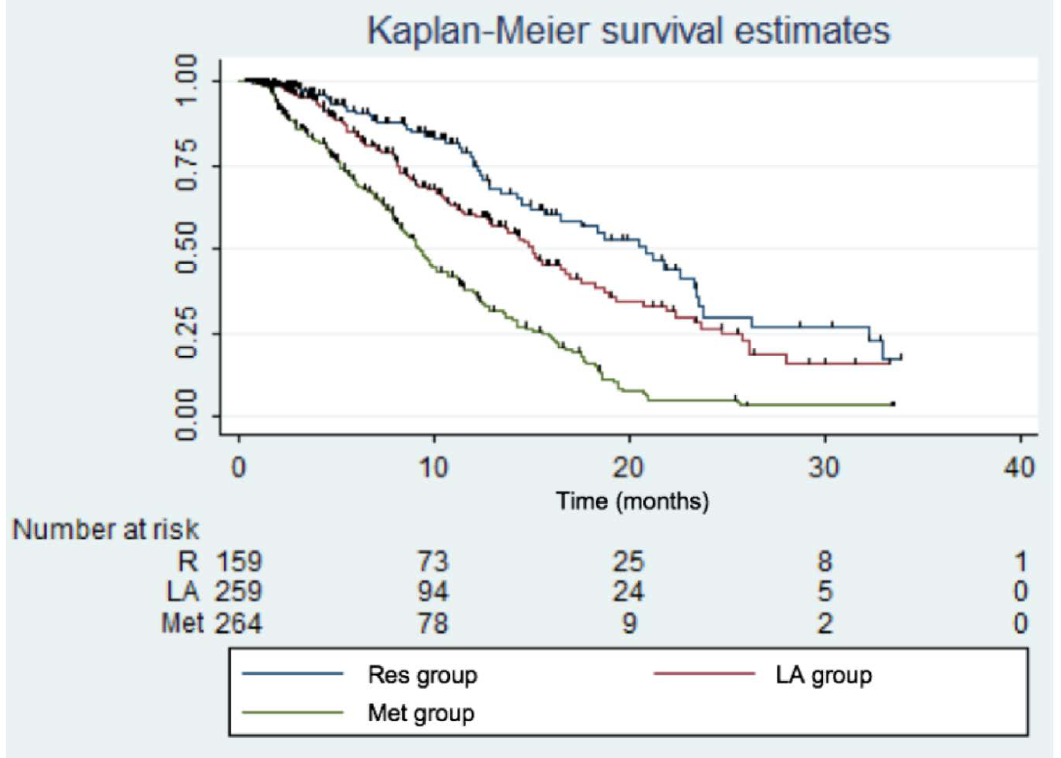
Figure 2. Kaplan–Meier survival estimates according to each group. Res: resectable; LA: locally advanced; Met: metastatic. Log-rank test: p < 0.001.